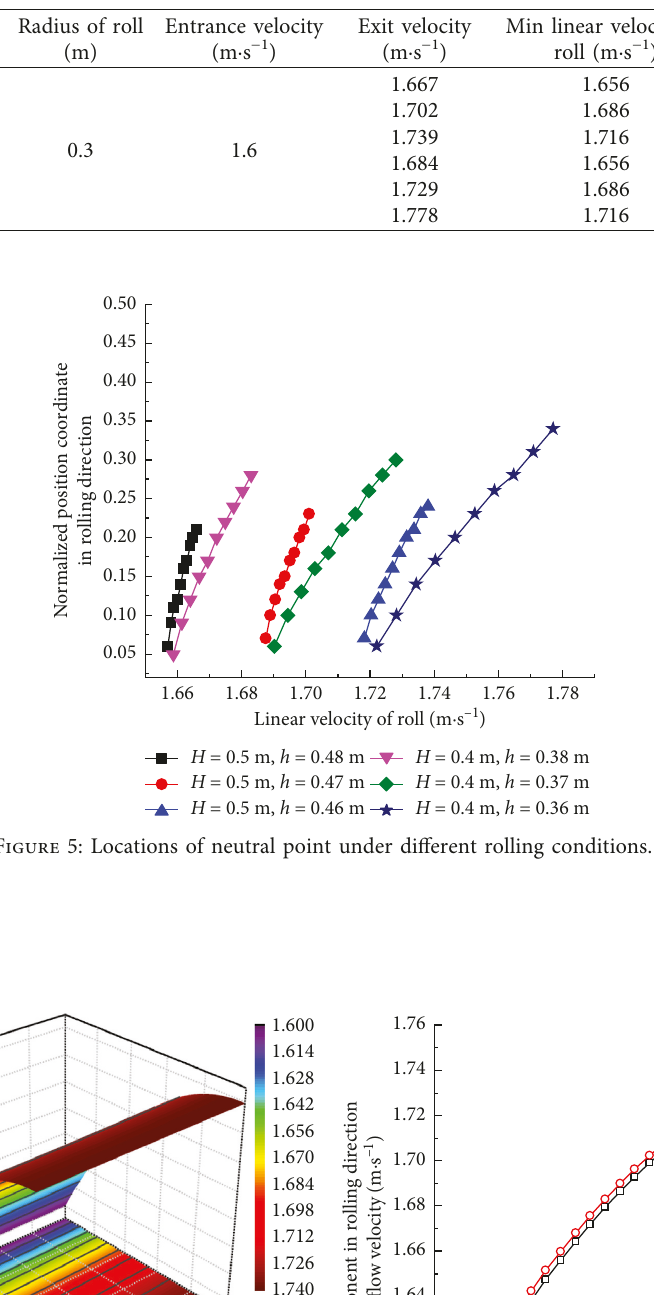
Table 2: Rolling parameters applied in the metal flow model.